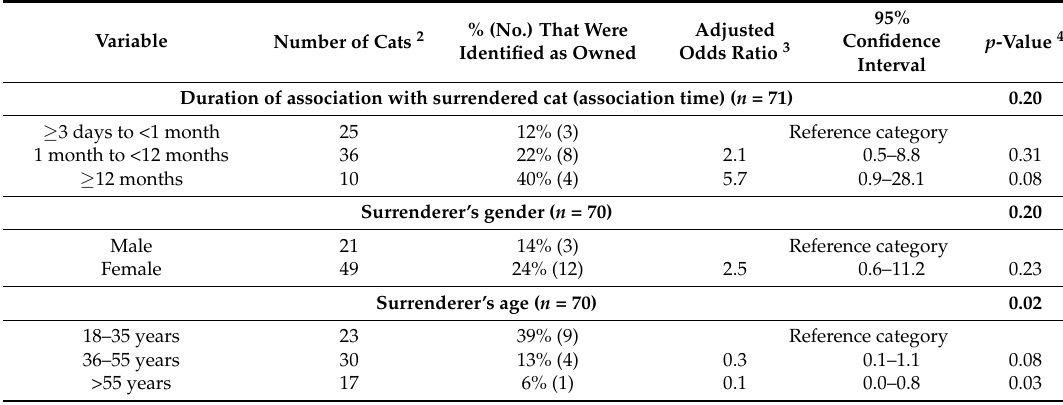
Table 4. Putative determinants 1 of surrenderer’s perceived ownership at time the cat was surrendered for 71 passively acquired